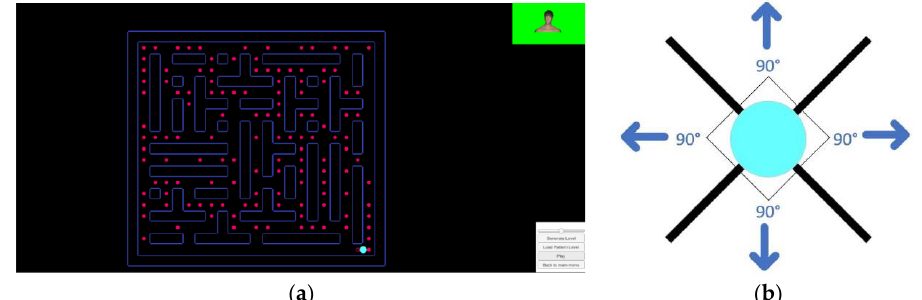
Figure 6. Interface of the game ( a ) and its control principle ( b ).